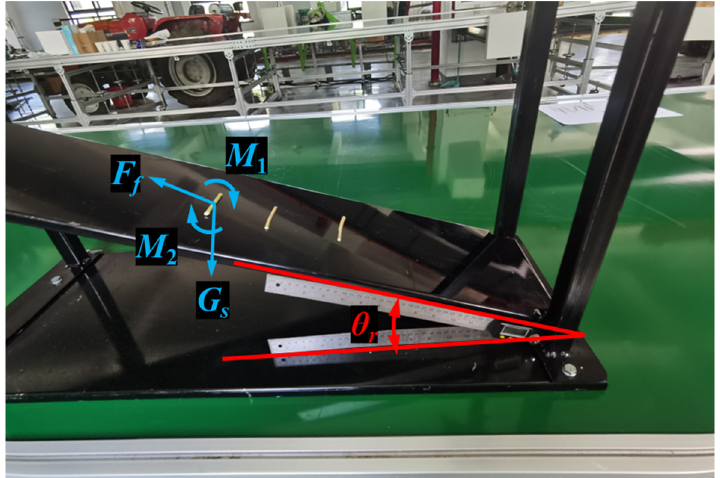
Figure 4. Coefficient of rolling friction test method. θ r is the angle between base plate and frame, (°); G s is rape stem gravity, N; F f is rolling resistance, N; M 1 is rolling torque, N·m; M 2 is rolling resistance torque, N·m.